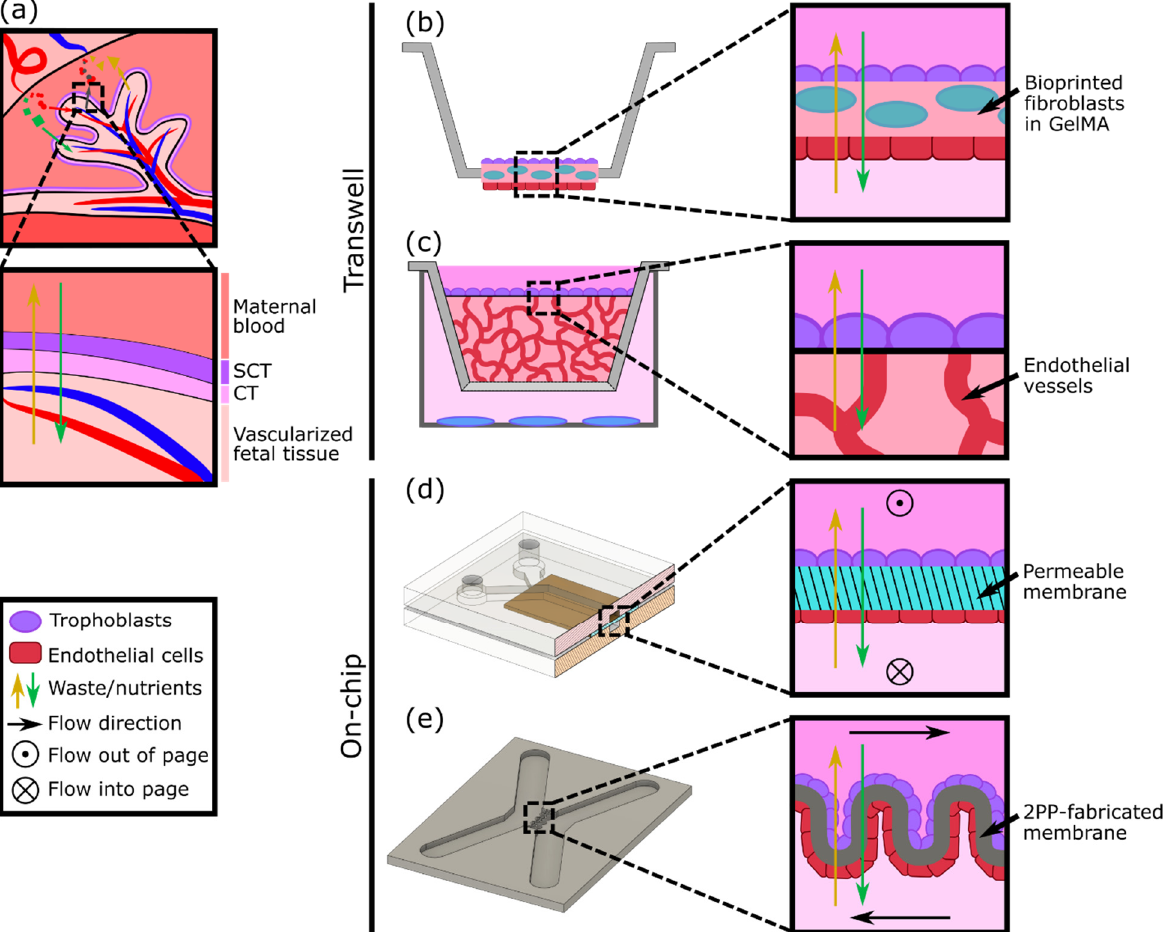
Figure 2. Modeling the placental barrier in vitro. ( a ) Diagram of transport between maternal and fetal blood supplies across the syncytiotrophoblast (SCT) and cytotrophoblast (CT). ( b ) A modified transwell model using a bioprinted layer of fibroblasts with trophoblasts and endothelial cells cultured on either side (based on design in [26]). ( c ) A transwell model with a layer of trophoblasts cultured on top of vasculature in a 3D gel matrix. Other cell types (blue) can be cultured below the transwell to test the effect of cell secretions (based on design in [27]). ( d ) Endothelial cells and trophoblasts can be cultured on either side of a permeable membrane in a PDMS microfluidic device with flow (based on designs in [17,28]). ( e ) Endothelial cells and trophoblasts may also be cultured on either side of a 2PP-fabricated membrane to achieve different geometries (based on design in [29]).